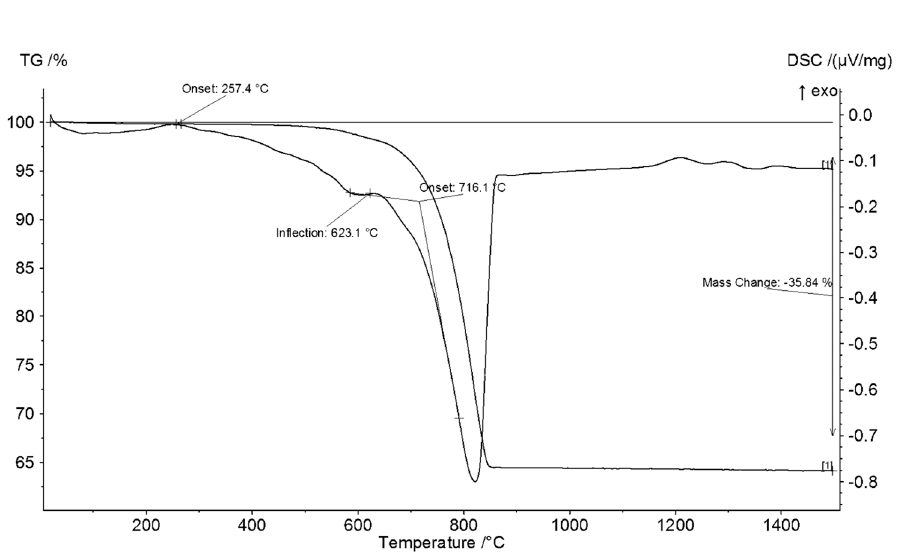
Figure 3 . TG-DSC analysis of the dolomite.